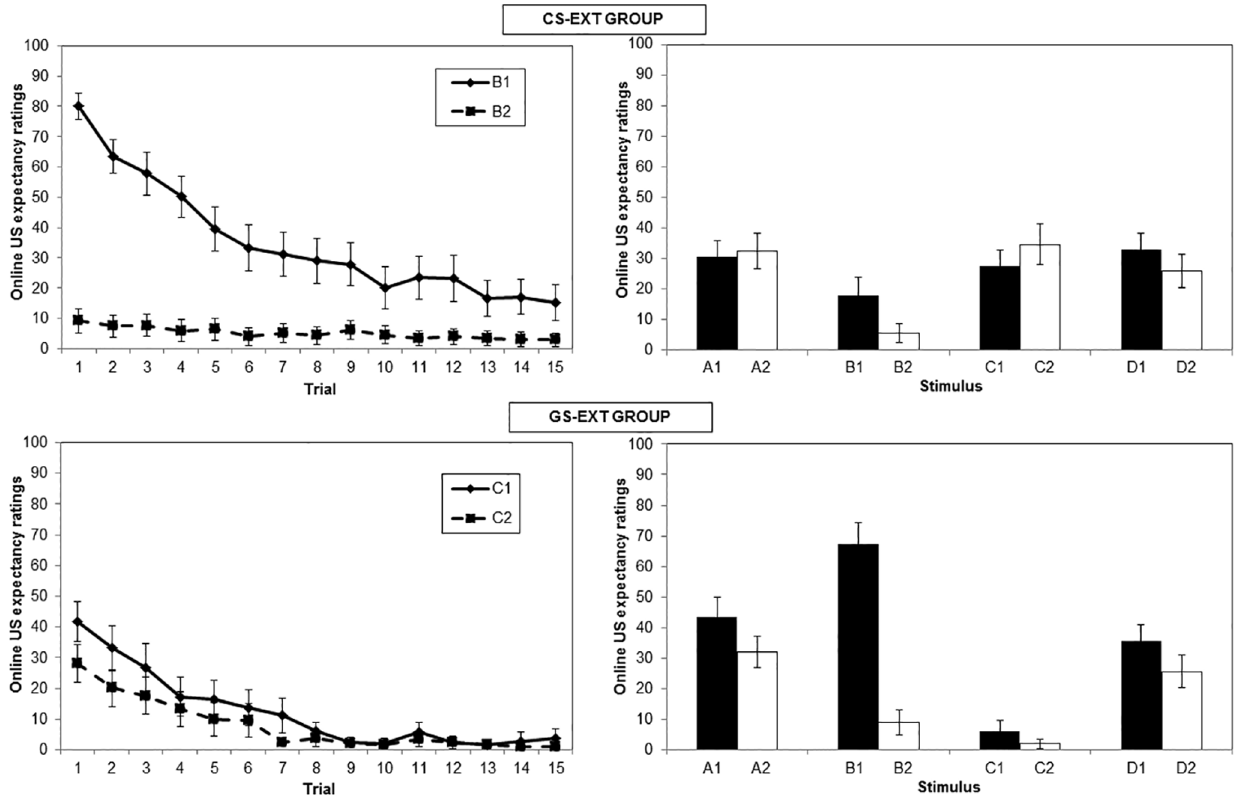
Figure 5. Mean expectancy ratings over the extinction phase and generalization of extinction test. Ratings were registered at the moment the stimulus and expectancy scale disappeared from the screen. Higher levels indicate more certainty about shock (100= ‘‘Certainly a shock’’), lower levels indicate more certainty about absence of shock (0= ‘‘Certainly no shock’’). The upper graph shows the data of CS-ext group, the lower graph the data of GS-ext group. The left panel represents the data from the extinction phase, per trial, for both B1 and B2 (group CS-ext) or C1 and C2 (group GS-ext). The right panel shows the data from the generalization of extinction test of all stimuli from both categories. Each stimulus was presented once during this phase.